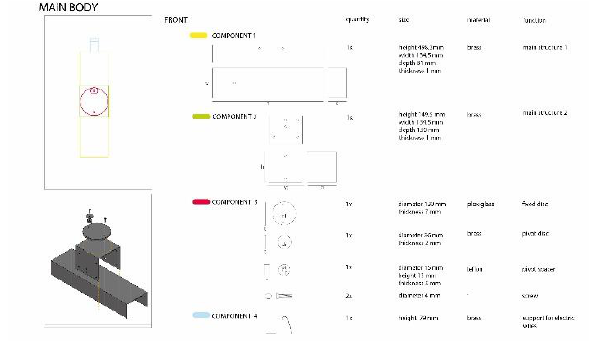
Fig.3.Abacus of the components